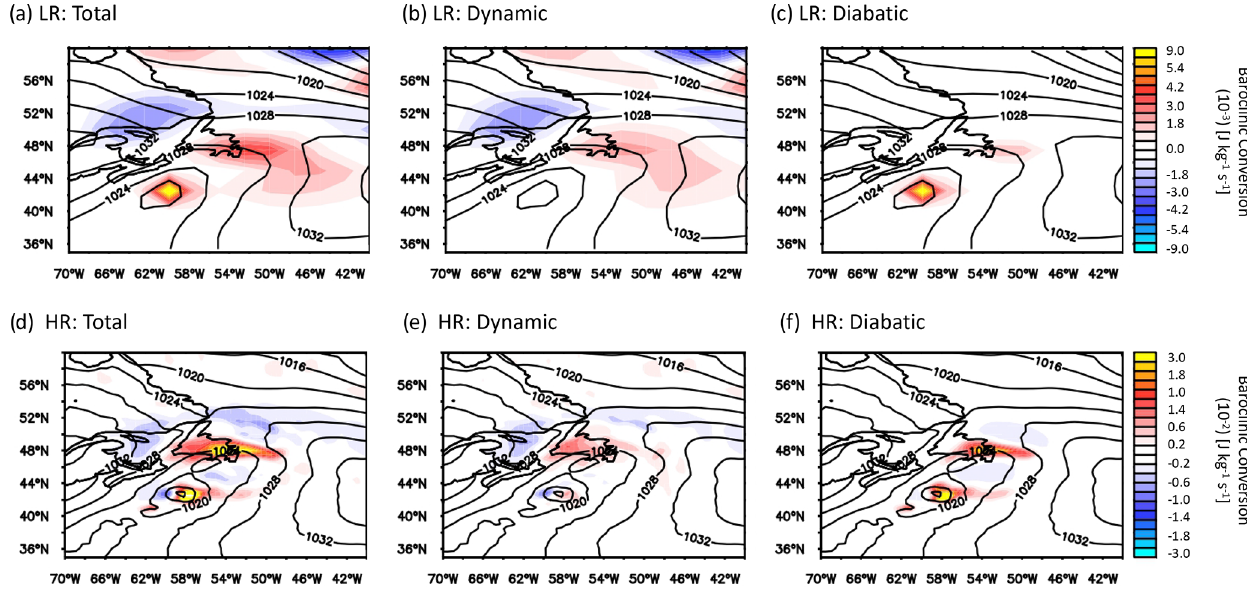
Figure 5. As in Fig. 4 but for LMDZ-LR (and -HR) hindcasts. Table 2. Distance and PV criteria from Boettcher and Wernli (2013) for identifying DRVs between T + 18 and T + 24 from the hindcast initialised at 00:00UTC 29 September. The PV criterion is based on a minimum PV value when averaged at the minimum MSLP location and the eight surrounding grid boxes, which is set to 0.8PVU. The distance criterion is based on a minimum distance travelled by the vortex in 6h, which is 250km. When the threshold is reached a (cid:88) is present, otherwise a × . The DRV is described as quantitative if all the thresholds are reached and qualitative otherwise. Only criteria for which at least one of the hindcasts do not meet the criteria are shown.